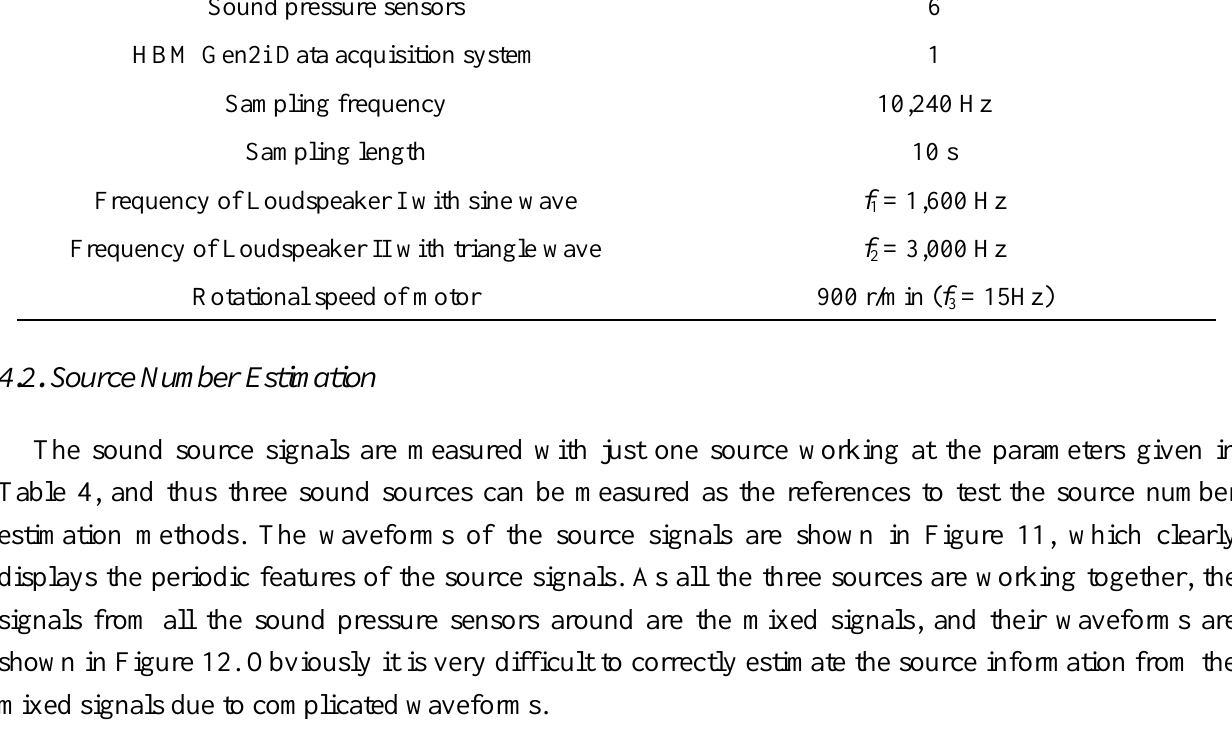
Figure 11. Waveforms of the source